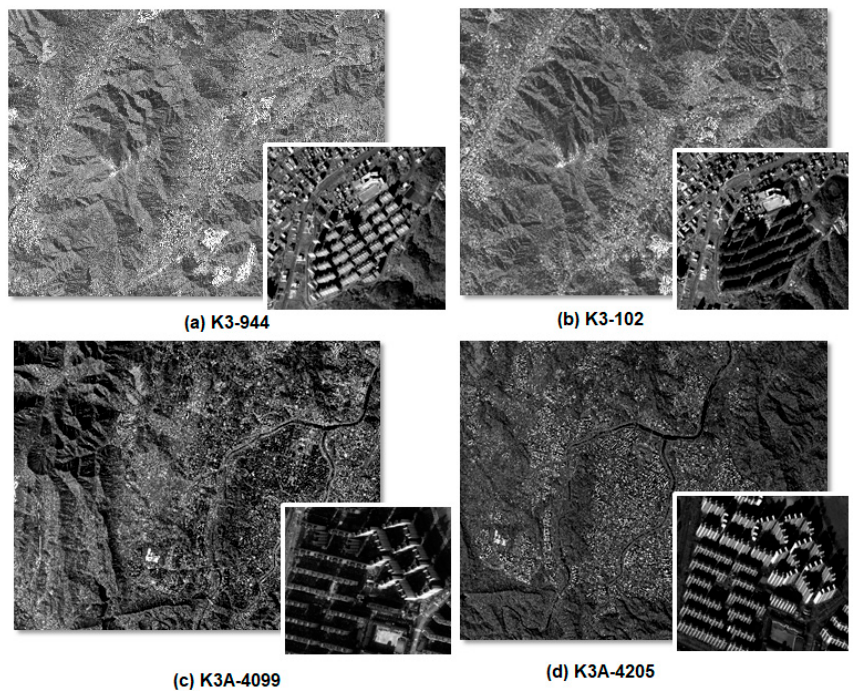
Figure 4. Test Kompsat-3 along-track stereo images (K3-944 and K3-102) and Kompsat-3A across-track stereo images (K3A-4099, K3A-4025). Remote Sens. 2020 , 12 , x FOR PEER REVIEW